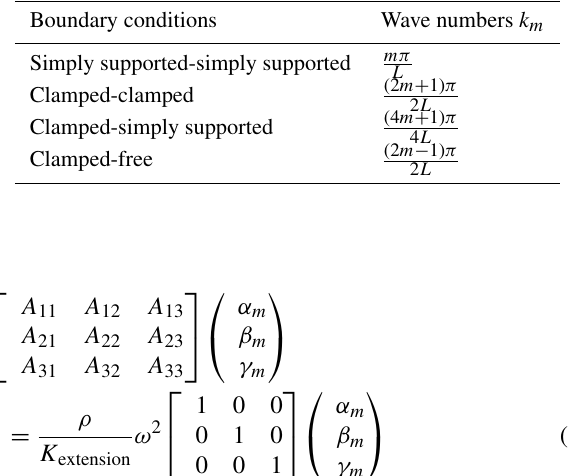
Table 1. Axial wave numbers for different boundary conditions. Boundary